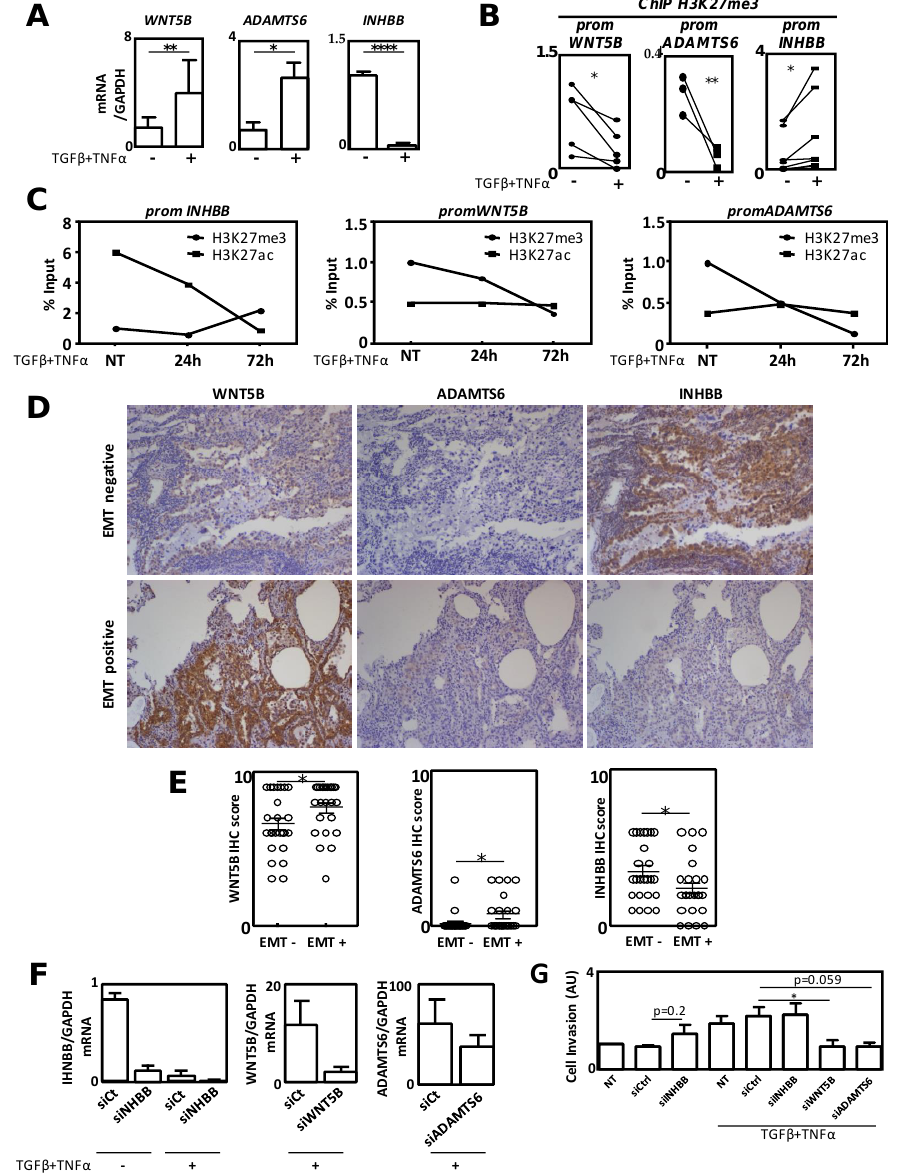
Figure 5. WNT5B, ADAMTS6, and INHBB were established as new epigenetic markers of EMT. ( A ) The validation of our biomarkers using classical ChIP targeting the H3K27me3 status on WNT5B , ADAMTS6 , and INHBB promoters following TGF β / TNF α treatment. ( B ) Validation using RT-qPCR of WNT5B , ADAMTS6 , and INHBB expression following TGF β / TNF α treatment. ( C ) Quantification of H3K27me3 and H3K27ac contents on INHBB , WNT5B , and ADAMTS6 promoters following TGF β / TNF α treatment for 24 to 72 h in A549 cells. ( D ) Representative IHC stainings of WNT5B, ADAMTS6, and INHBB in EMT-positive and EMT-negative NSCLCs (magnification × 100). ( E ) Quantification of IHC scores in regards to EMT status. ( F ) Validation of siWNT5B , siADAMTS6 , and siINHBB using qRT-PCR. ( G ) E ff ects of siWNT5B , siADAMTS6 , and siINHBB on A549 cell invasion. * = 0.01 < p < 0.05; ** = 0.005 < p < 0.01; **** = p <